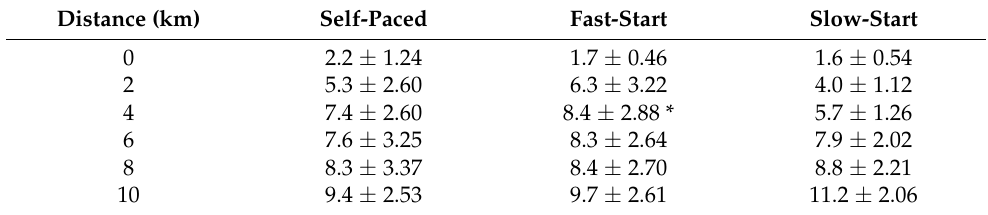
Table 5. Means ± standard deviations of blood lactate concentration (mmol · L − 1 ) during self-paced, fast-start, and slow-start time